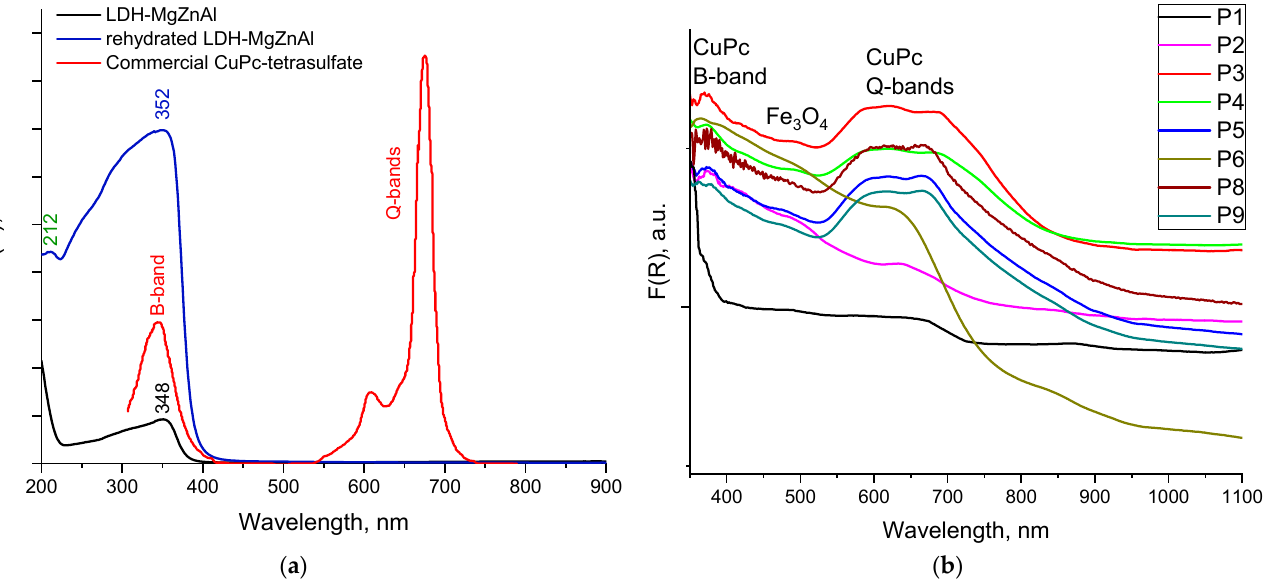
Figure 2. DR-UV-VIS spectra collected for ( a ) as-prepared and rehydrated LDH, commercial CuPc tetrasulfate, and ( b ) P1–P8 catalysts.